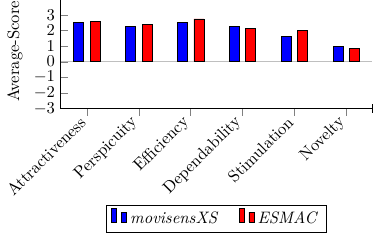
Figure 3: UEQ results for both web